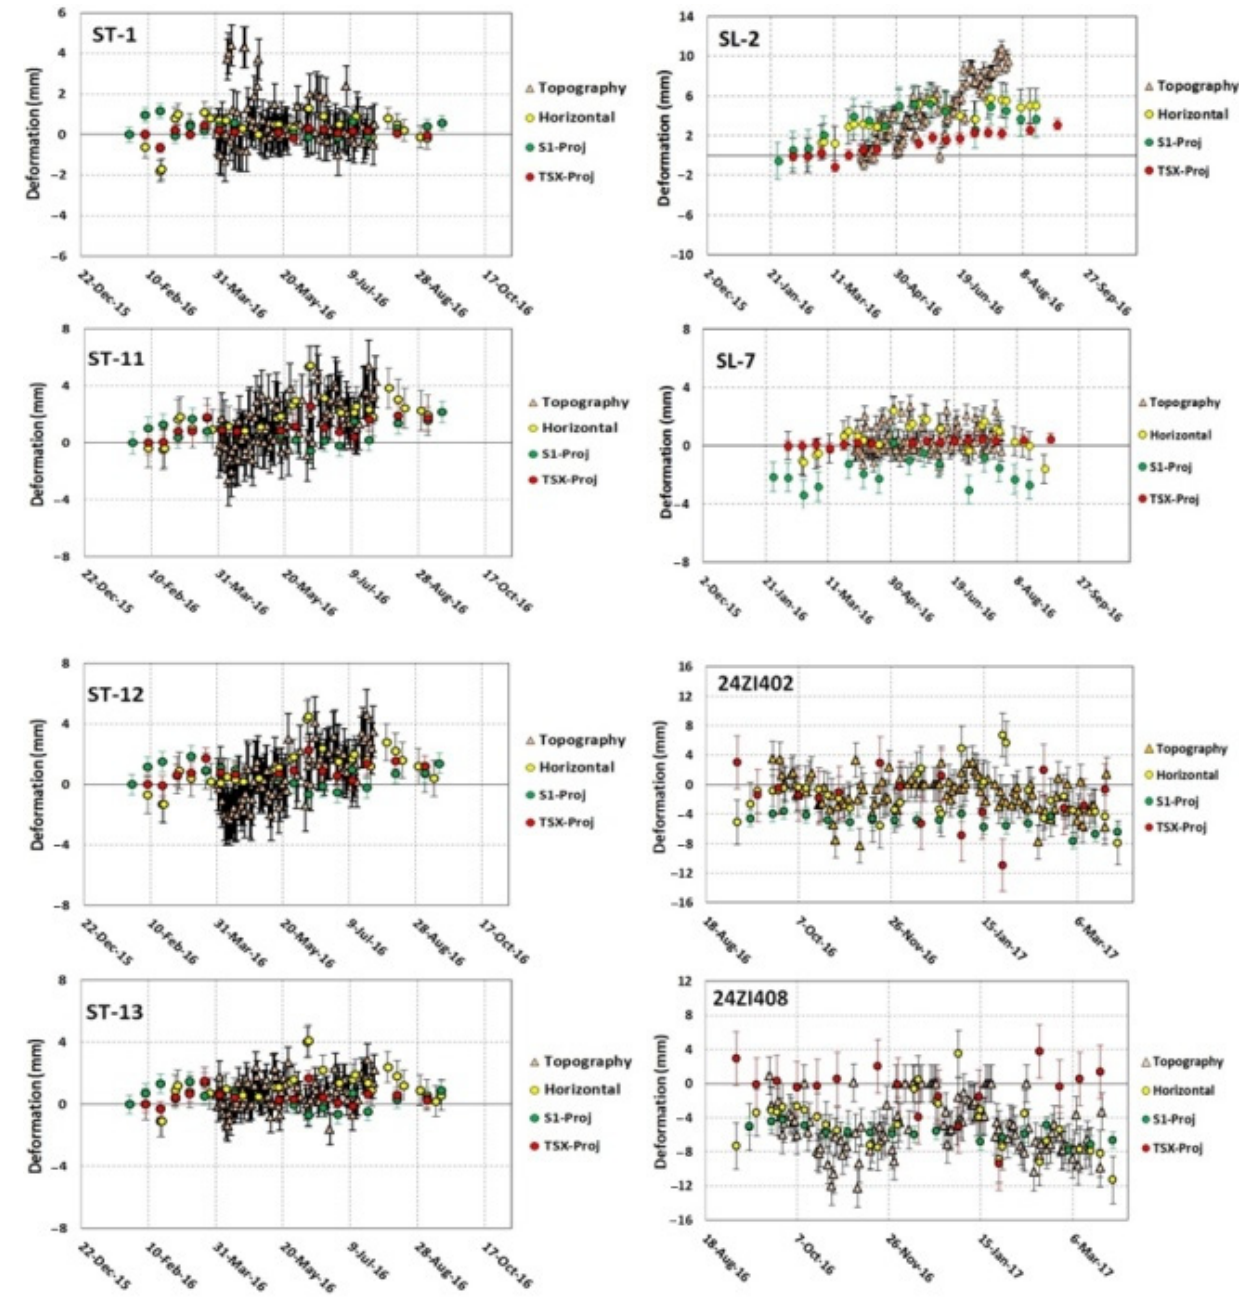
Figure 8. Horizontal ground deformation of the prisms locations (MP projected and MP decom- posed) and TS (horizontal topographic measurements): ST-1; ST-11; ST-12; ST-13, SL-2; SL-7; 24ZI402; 24ZI408.